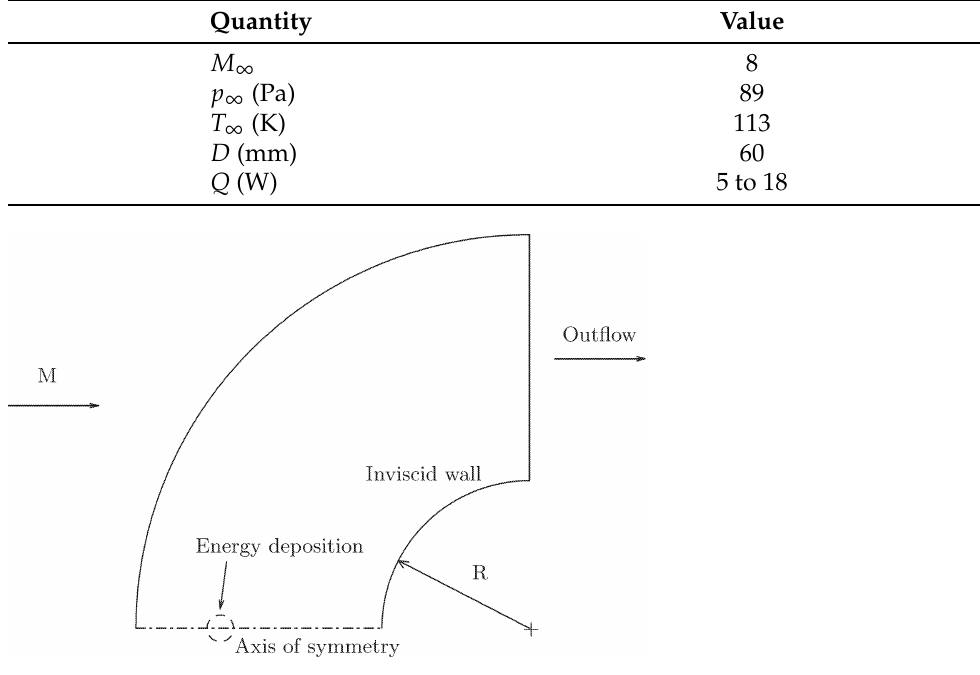
Figure 46. Flow configuration.